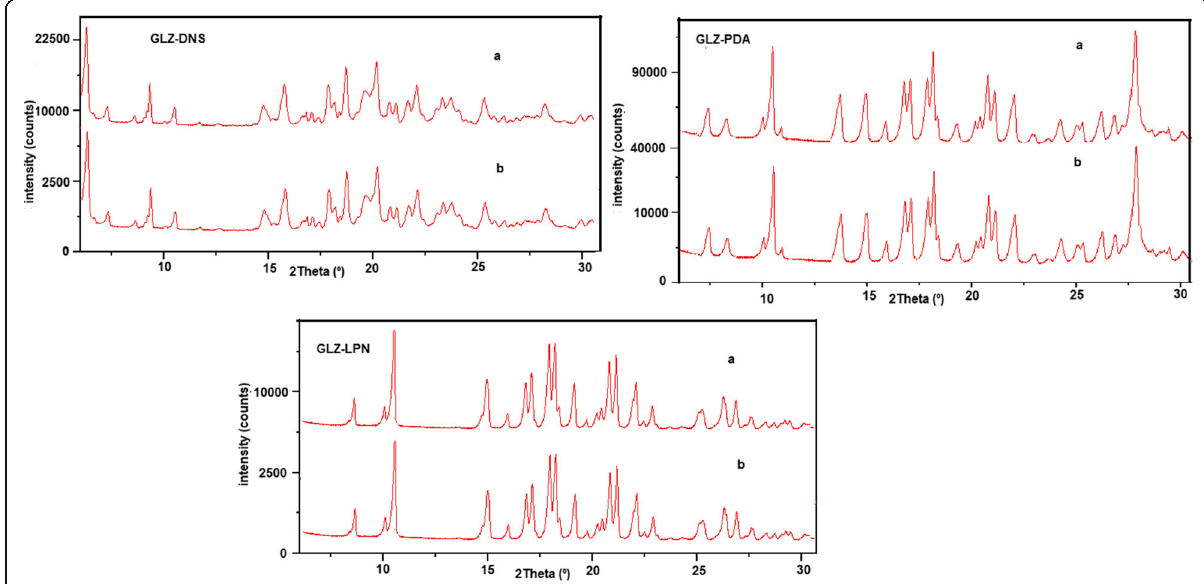
Fig. 5 Phase transformation studies of GLZ – DNS, GLZ – PDA, and GLZ – LPN cocrystals; a before-phase transformation studies and b after-phase transformation